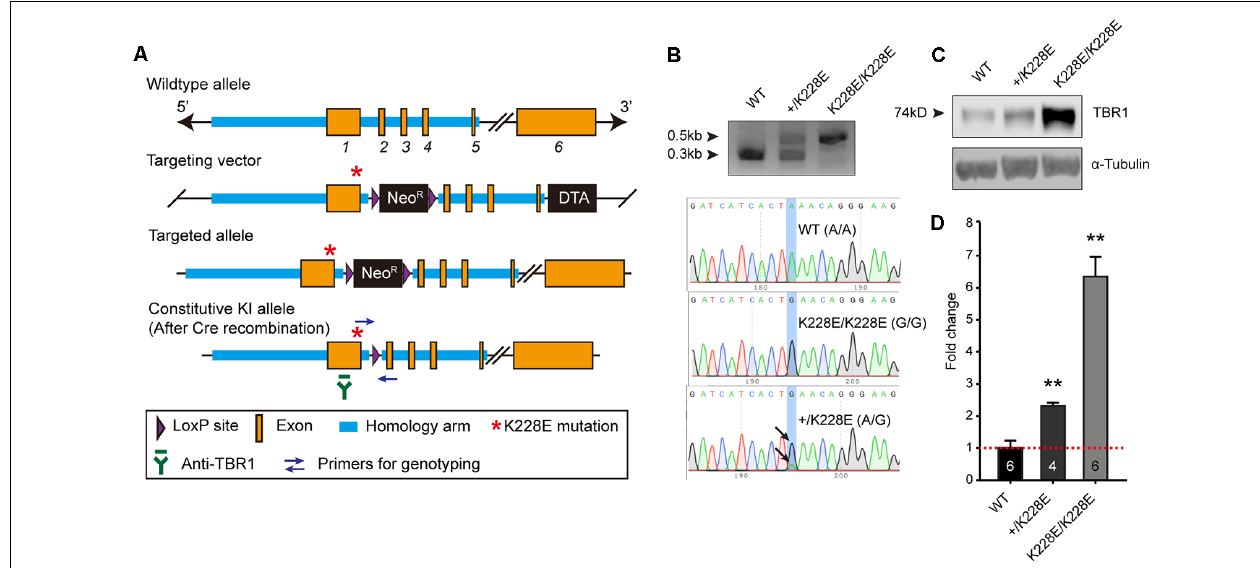
FIGURE 2 | Generation and basic characterization of Tbr1 + / K228E and Tbr1 K228E / K228E mice. (A) Tbr1 gene knock-in (KI) strategy. Note that the TBR1-K228E mutation is located in exon 1 of the Tbr1 gene. (B) PCR genotyping and confirmation of the TBR1-K228E mutation by DNA sequencing in WT, heterozygous ( Tbr1 + / K228E ), and homozygous ( Tbr1 K228E / K228E ) mice (E16.5). (C,D) Increased levels of TBR1 protein in Tbr1 + / K228E and Tbr1 K228E / K228E brains compared with that in WT brains (E17; males and females), determined by immunoblot analysis of TBR1 protein ( ∼ 74 kDa) and quantification of TBR1 signals normalized to α -tubulin. The image shown is an example from male mouse samples. Note that levels of the TBR1-K228E protein are strongly increased in a gene dosage-dependent manner. n = 6 mice for WT, four mice for Tbr1 + / K228E , and six mice for Tbr1 K228E / K228E , ∗∗ P < 0.01 vs. WT, Mann–Whitney